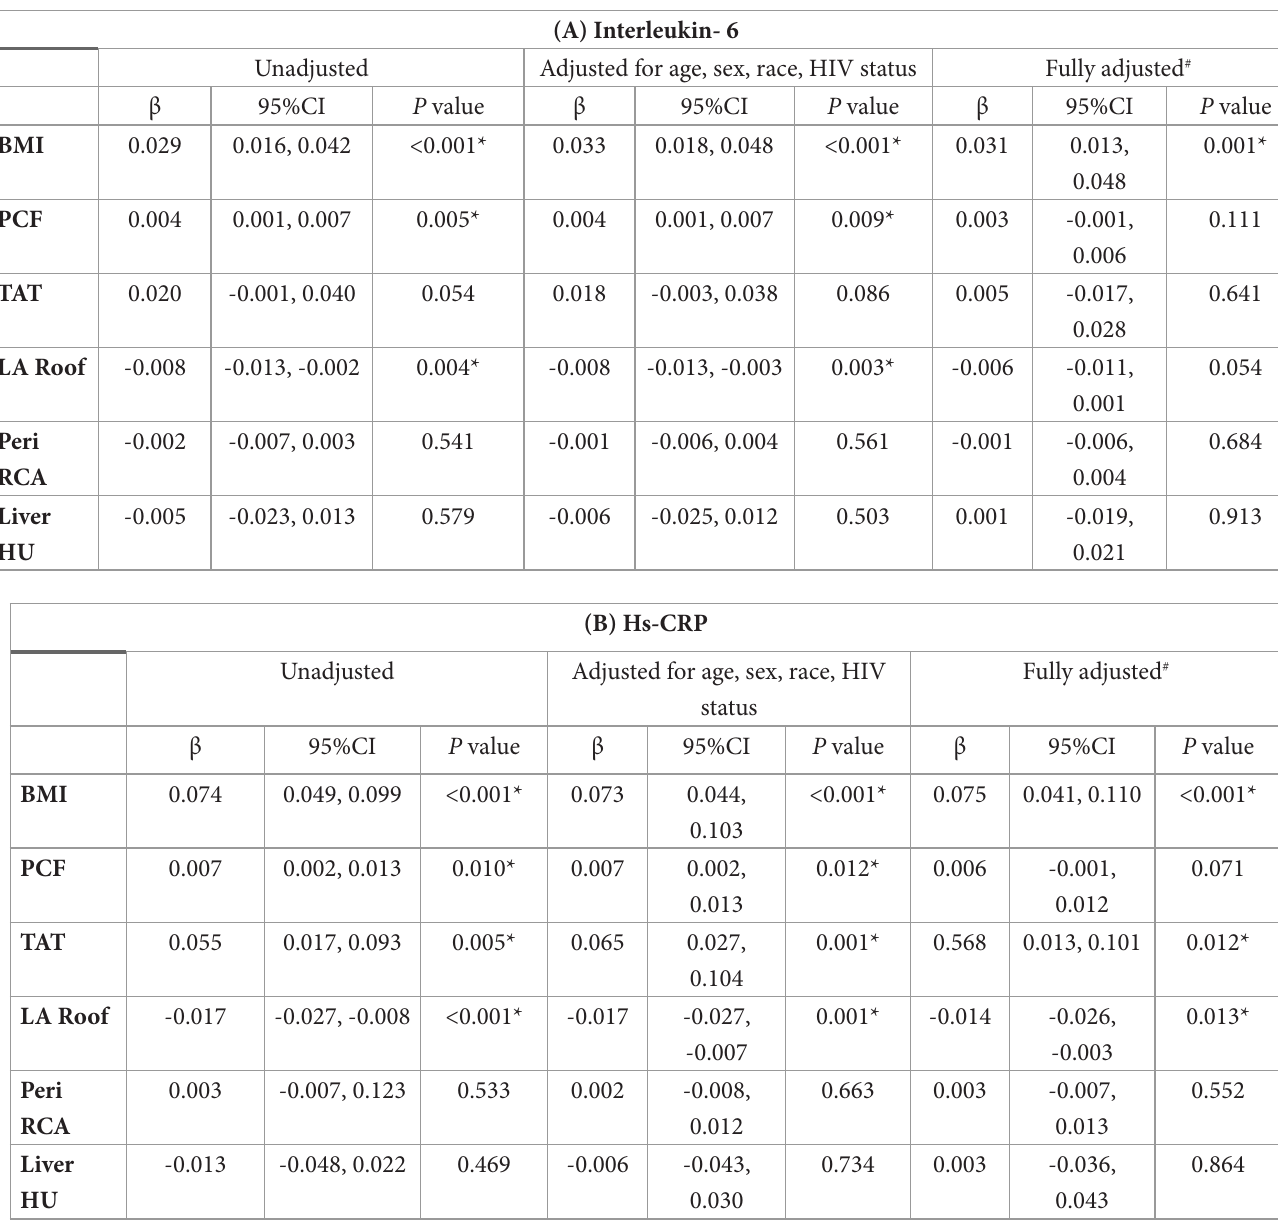
Table 3. Association of BMI and Ectopic Fat Measures with Natural-Log-Transformed IL-6 and hs-CRP in Unadjusted and Adjusted Linear Regression Models (A) Interleukin-